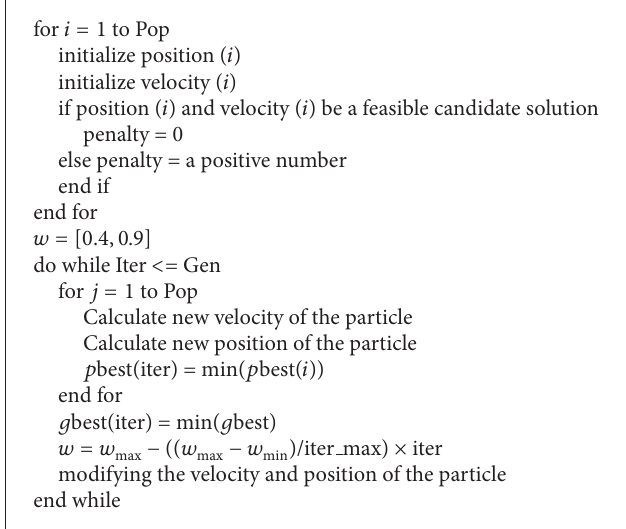
Pseudocode 1: The pseudocode of MOPSO algorithm.